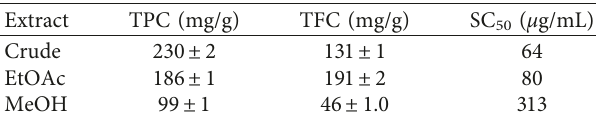
Table 5: Total phenolic content and total flavonoid content in crude, EtOAc, and MeOH extracts of Mangifera indica